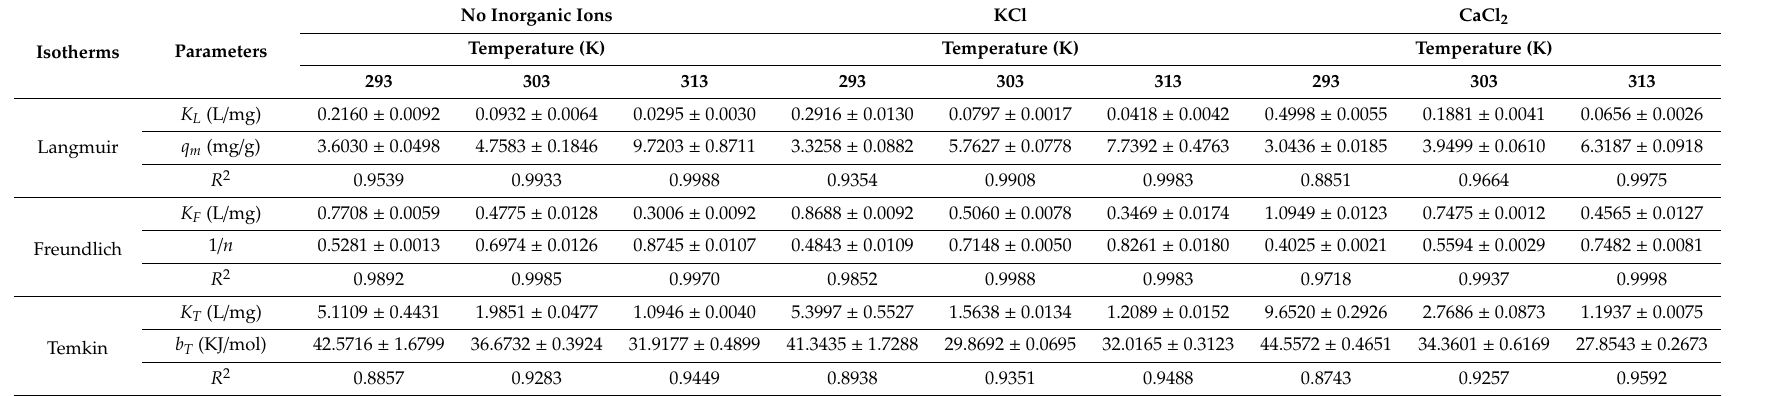
Table 4. Summary of results from the equilibrium isotherm model